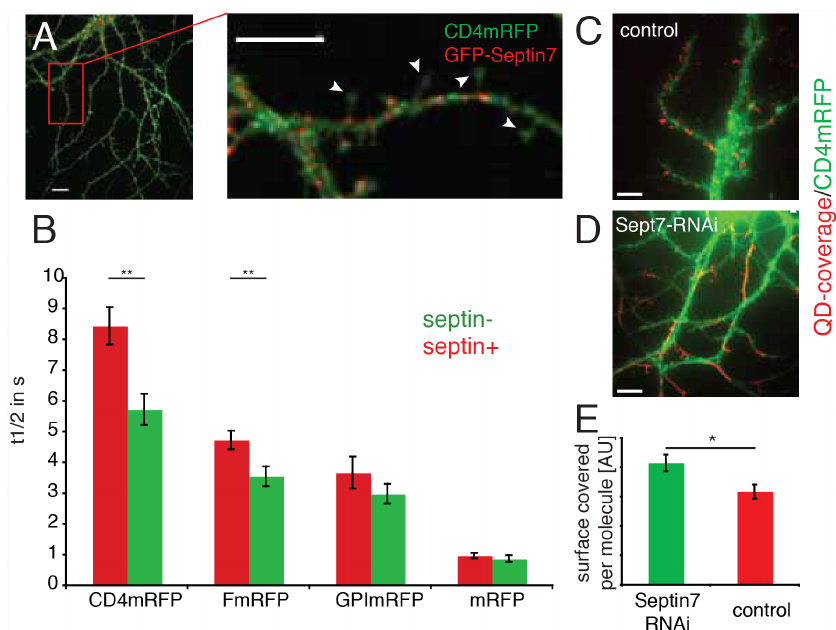
Fig. 4. Sept7 and membrane flow in dendritic spines. (a) Fluorescence image of hippocampal neuron expressing Sept7-GFP and CD4-mRFP for 2 weeks (DIV7 + 14), inset is showing spines that were selected for FRAP analysis. Scale bar is 5 m m. (b) Graph of CD4-mRFP, F-mRFP, GPI-mRFP and mRFP fluorescence- recovery halftimes in Sept7-GFP positive (red) and Sept7-GFP negative (green) spines. All experiments were done in $ 3 neurons in $ 10 spines. **p , 0.01, Mann-Whitney test. (c, d) Maximum projection of movies of CD4-mRFP coupled QDs on neurons transfected with control RNAi (c) or Sept7 RNAi (d), illustrating the total area browsed by diffusing molecules (red). The CD4-mRFP staining of the cell is shown in green. Note that on Sept7 RNAi treated neurons QDs move great distances and browse many spines. Scale bars are 5 m m. (e) Quantification of CD4-mRFP mobility on Sept7 (green) or control (red) shRNA treated cells. Shown is the absolute area covered per quantum dot in m m 2 . *p , 0.05, Mann-Whitney test. Shown are experiment performed in 3 cultures in 31 cells with a total of 994 QDs.